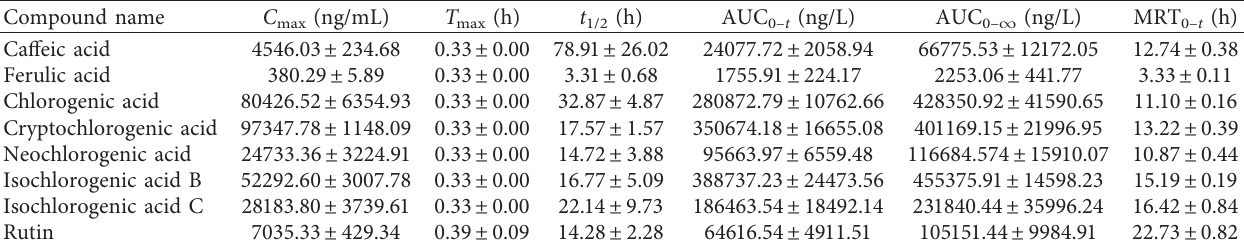
Table 7: Pharmacokinetic parameters of the 8 compounds in rats after oral administration of H-FF extracts (mean ± SD, n �